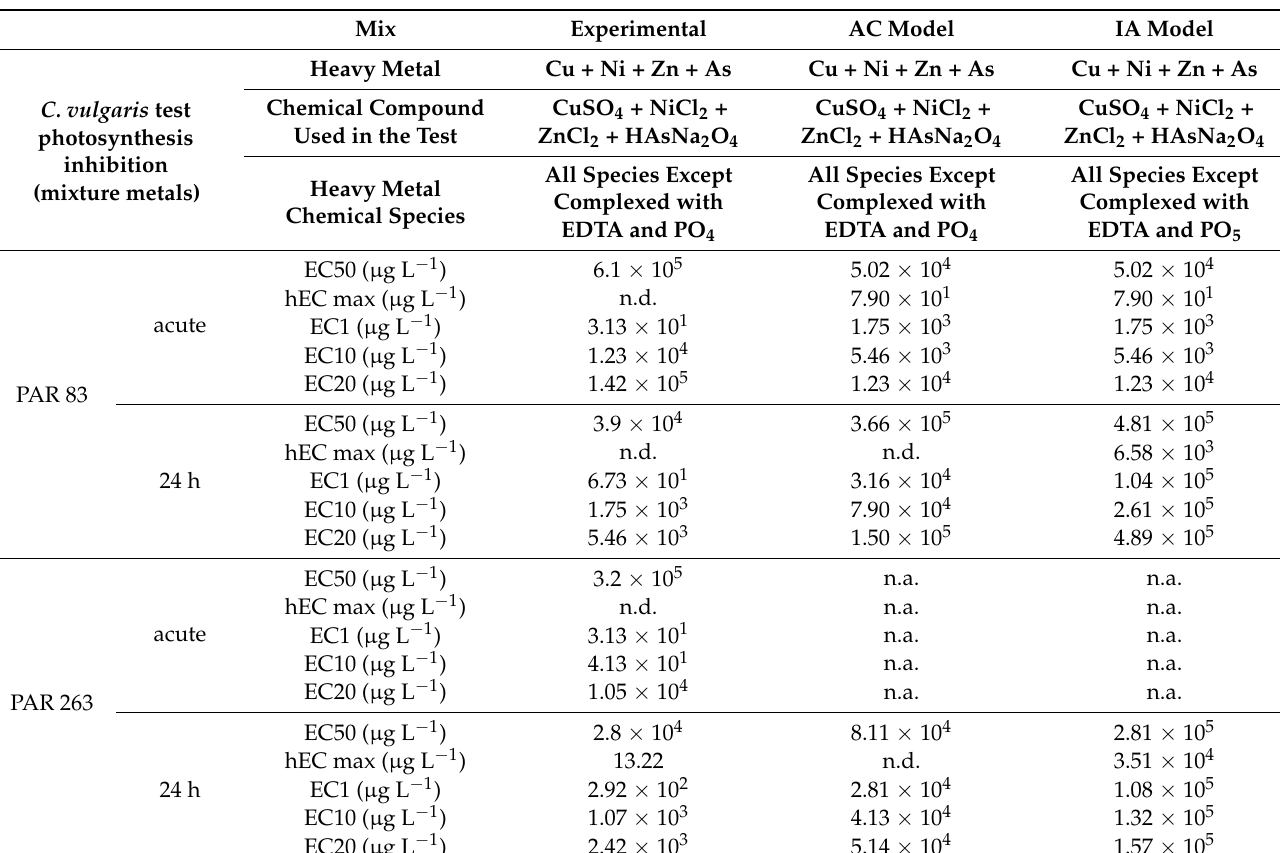
Table 3. Maximum stimulation concentration (hEC) and selected effective concentrations (ECx, ppb) of YII in artificial heavy metal mixtures and modeled with the AC model and calculated with Matlab concentration-response